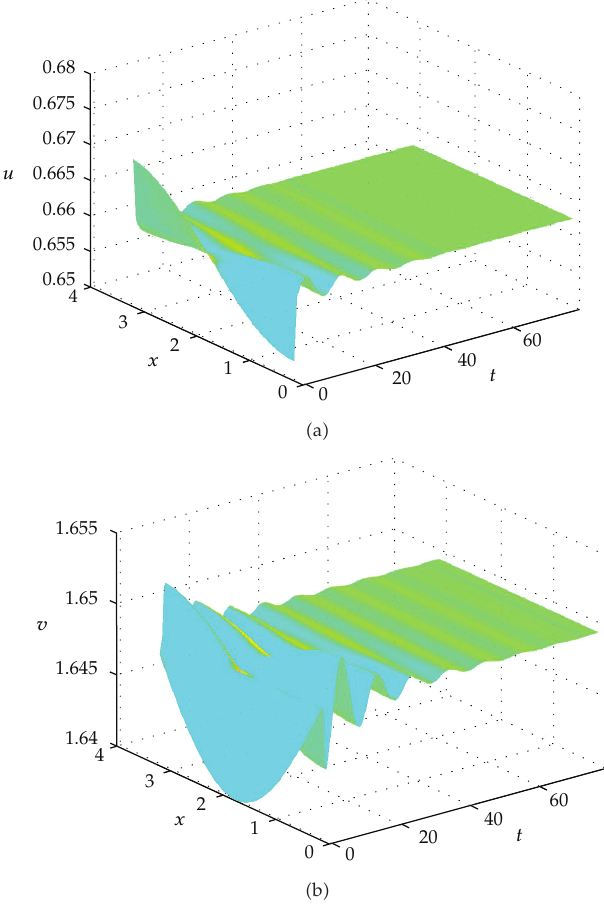
Figure 2: The solution of system (cid:6) 1.7 (cid:7) tends to the positive equilibrium E ∗ . The parameters are taken as α (cid:5) 2, β (cid:5) 0 . 2, γ (cid:5) 0 . 5, b (cid:5) 2, c (cid:5) 3, m (cid:5) 1, d 1 (cid:5) 0 . 01, d 2 (cid:5) 0 . 1, τ (cid:5) 0 . 9, and the initial values u (cid:6) x,t (cid:7) (cid:5) 0 . 662 (cid:8) 0 . 01 t cos x , v (cid:6) x,t (cid:7) (cid:5) 1 . 649 (cid:8) 0 . 01 t sin x , t ∈ (cid:3) − 0 . 9 , 0 (cid:4) , x ∈ (cid:3) 0 ,π (cid:4) . In this case, τ < τ 0